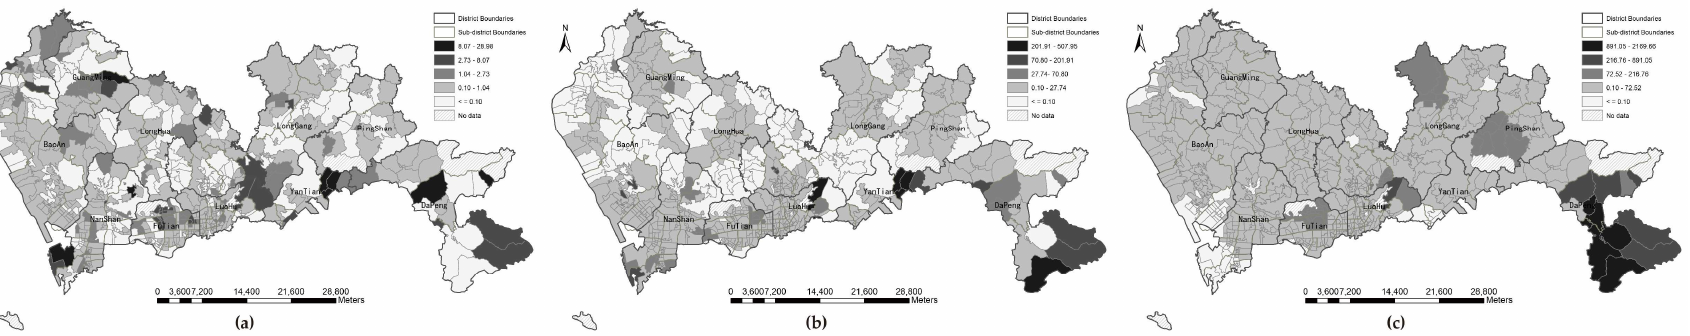
Figure 9. Park accessibility by driving distance at three park levels: ( a ) community park level; ( b ) city park level; ( c ) natural park